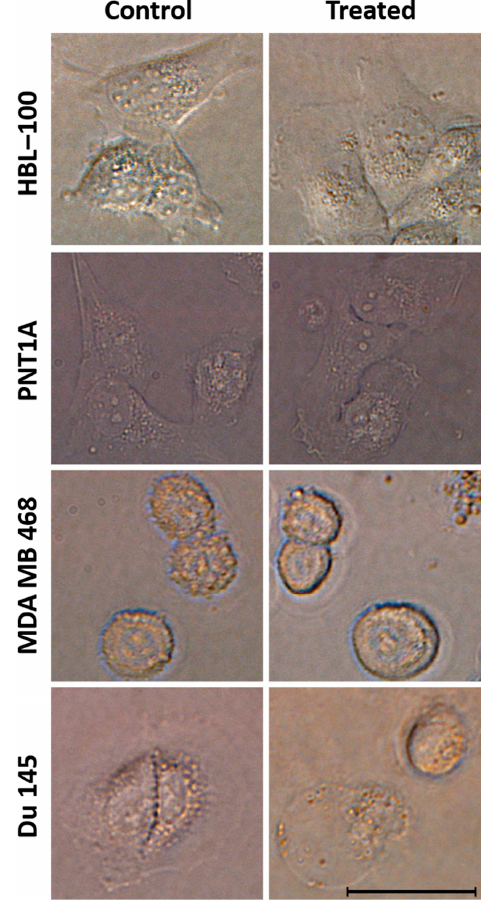
Figure 8. The microscopic image of four types of human cell lines (HBL–100, PNT1A, MDA MB 468, and Du–145) after treatment using HSER–CQDs. Scale is 20 µm.